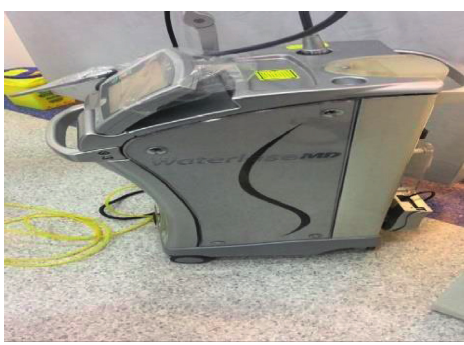
Figure 2: Er, Cr: YSGG laser device.